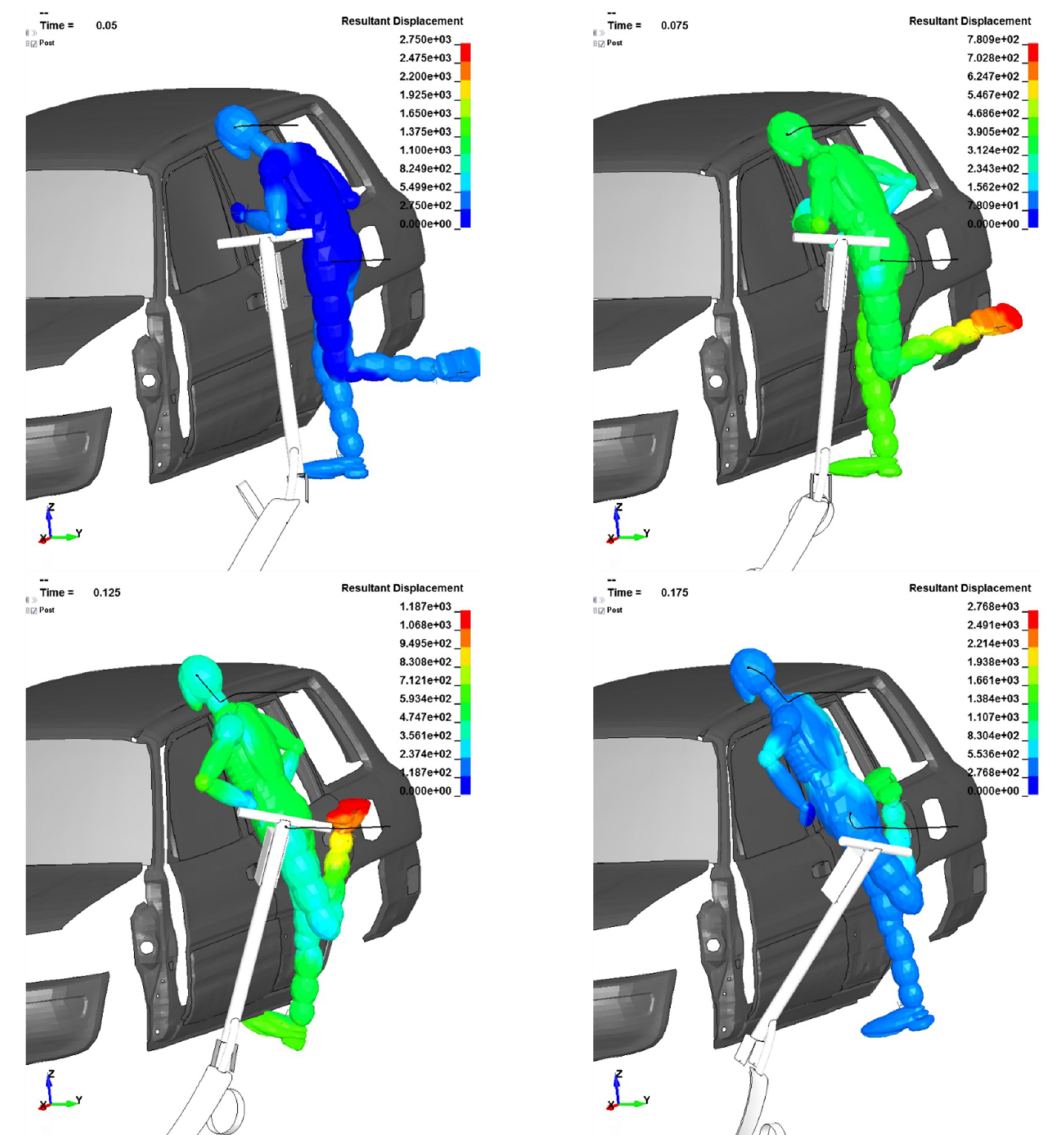
Fig 7. Dummy kinematics in the B-pillar, squat scenario—The dummy’s resultant displacement in [mm], time in